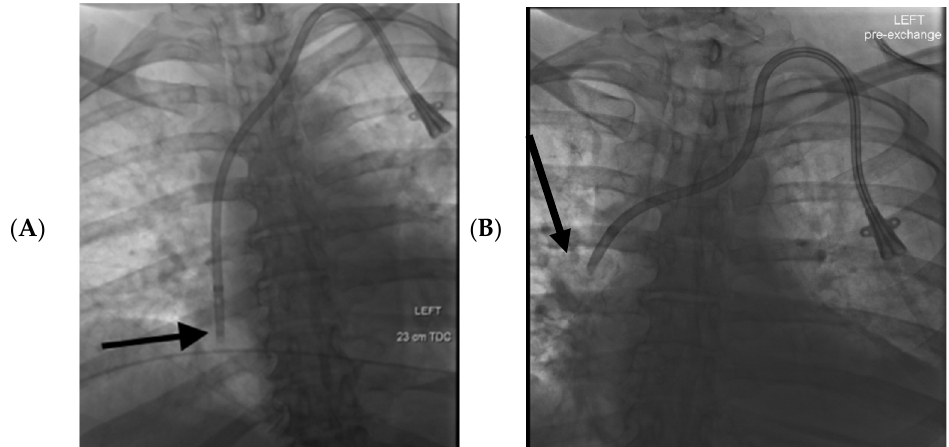
Figure 2. 57-year-old female had a history of end stage renal disease with a left-sided tunneled dialysis catheter. ( A ): The initial supine fluoroscopic images at the time of catheter placement demonstrated the catheter tip within the mid right atrium (black arrow). ( B ): Two months later the patient presented with catheter dysfunction, and supine fluoroscopic interrogation demonstrated that the tip of the catheter had migrated 6 cm cranially to the upper SVC (black arrow). Table 1. Patient and catheter characteristics were reported as total number and percent. The total number of catheters placed was 177, with the majority being placed on the right side (72%). The most common catheter type was a port (69%). There was a slight majority of female patients (57%). Gender 101 Female (57%) 76 Male (43%) Laterality 127 R (72%) 50 L (28%) Catheter type 122 Ports (69%) 50 lbTCVC (28%) 5 sbTCVC (3%) lbTCVC = Large bore tunneled dialysis catheter; sbTCVC = Small bore tunneled central venous